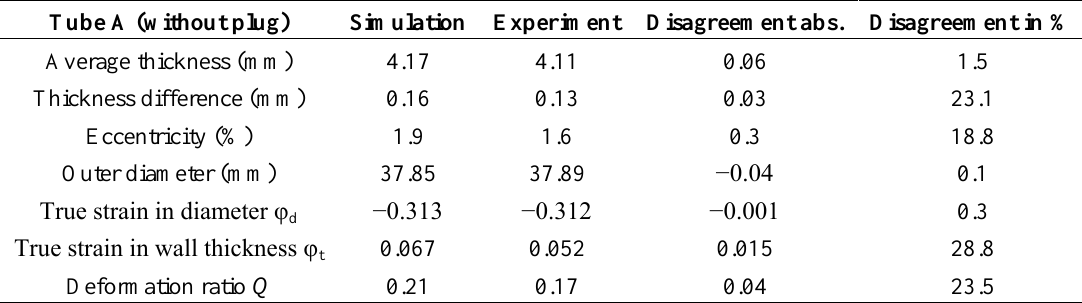
Table 2. Deviation between simulation and experiment evaluation of tube